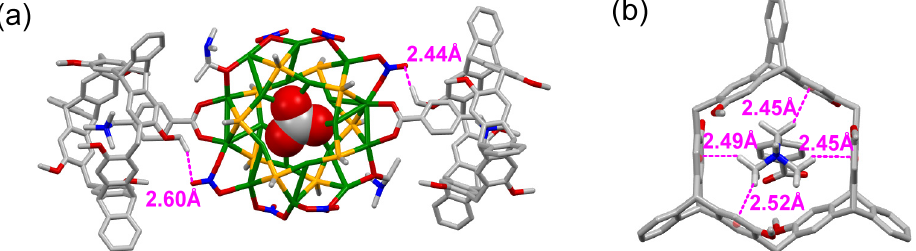
Figure 5. ( a ) DFT optimized structure of complex G @ P - H6 and the hydrogen-bonding distances between G and P - H6 . ( b ) The C − H ∙∙∙π interaction distances between the L1-H ligand of G and P - H6 . H atoms not involved in the noncovalent interactions were omitted for clarity. Color legend: Ag, green; S, orange; C, gray; N, blue; O, red.